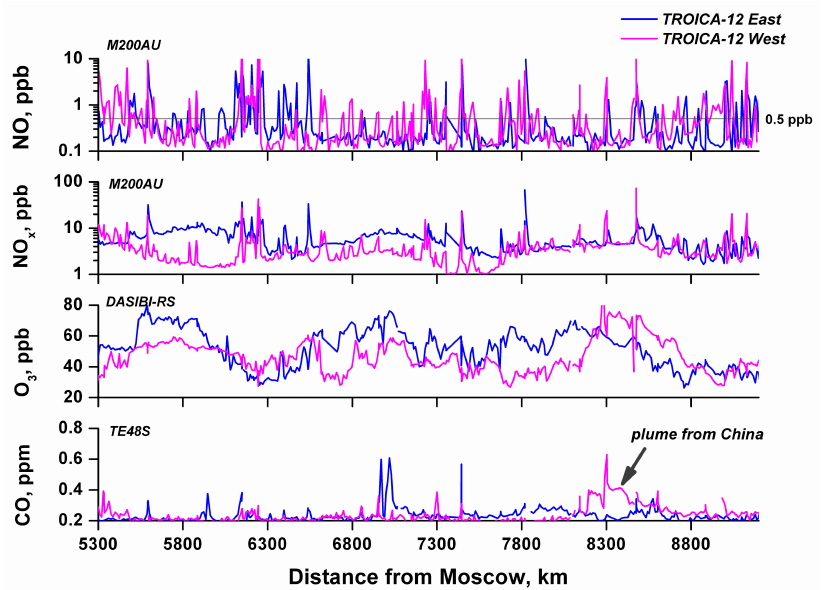
Figure 2. The 10-min averaged concentrations of NO, NO x , O 3 and CO, measured during the expeditions of TROICA-12 East and West on the stretch of the Trans-Siberian Railway from Lake Baikal to the Pacific Ocean coast. The CO concentrations are shown as an indicator of the long-range pollution transport. The arrow specifies a site corresponding to the long-distance pollution transport from the central regions of China, recorded during the expedition, TROICA-12 West .